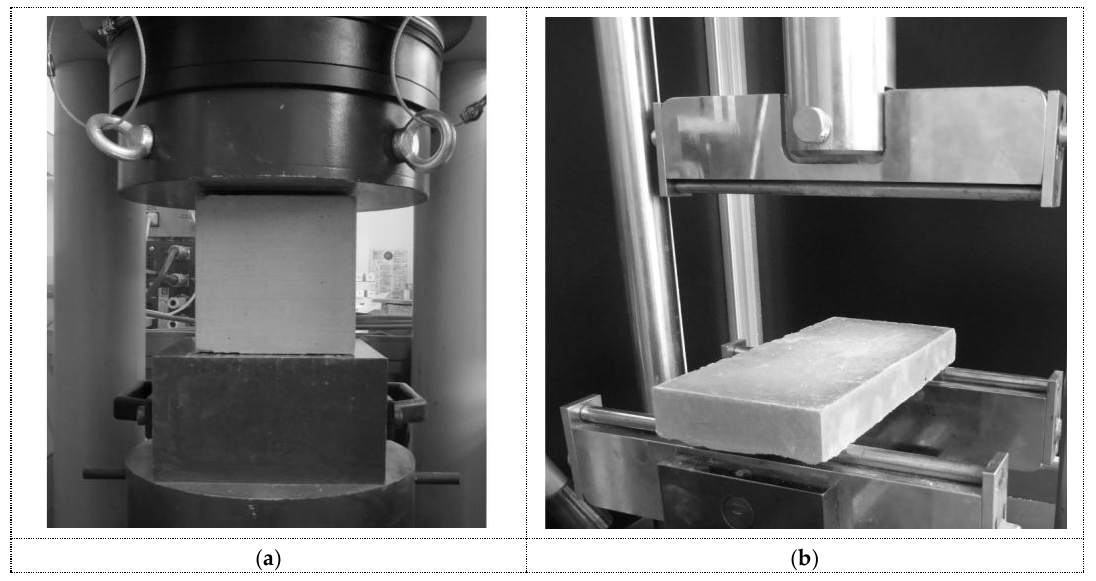
Figure 1. Determination of compressive strength ( a ) and three-point bending tensile strength ( b